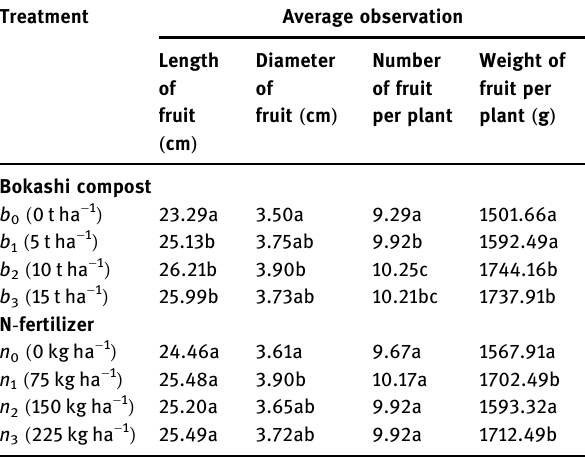
Table 3: Fermented compost and N - fertilizer on the plant height of the purple eggplant at 37 DAP B/N